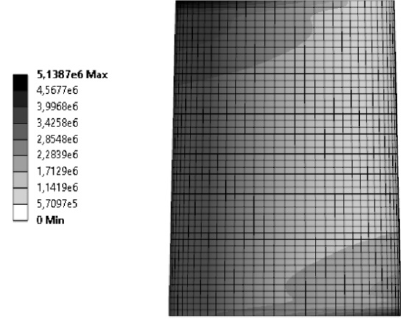
Figure 15. Pressure distribution (Pa) on the grout surface obtained from the static analysis.